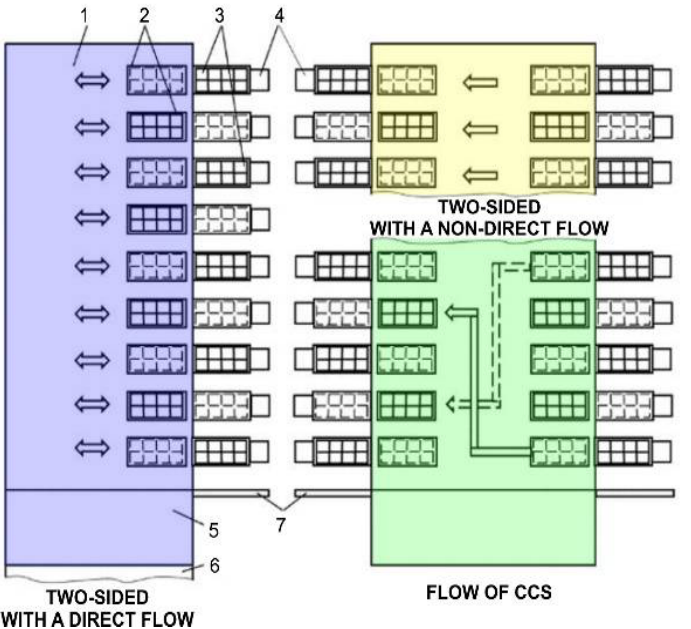
Figure 5. Type of CLN4.0 (top view): 1—CLN4.0, 2 – freight elevators, 3—CCs, 4—e-trucks, 5—area of the CLN4.0 for the placement of sanitary facilities, staircases, and passenger elevators, 6—shopping center with parking, 7—parcel